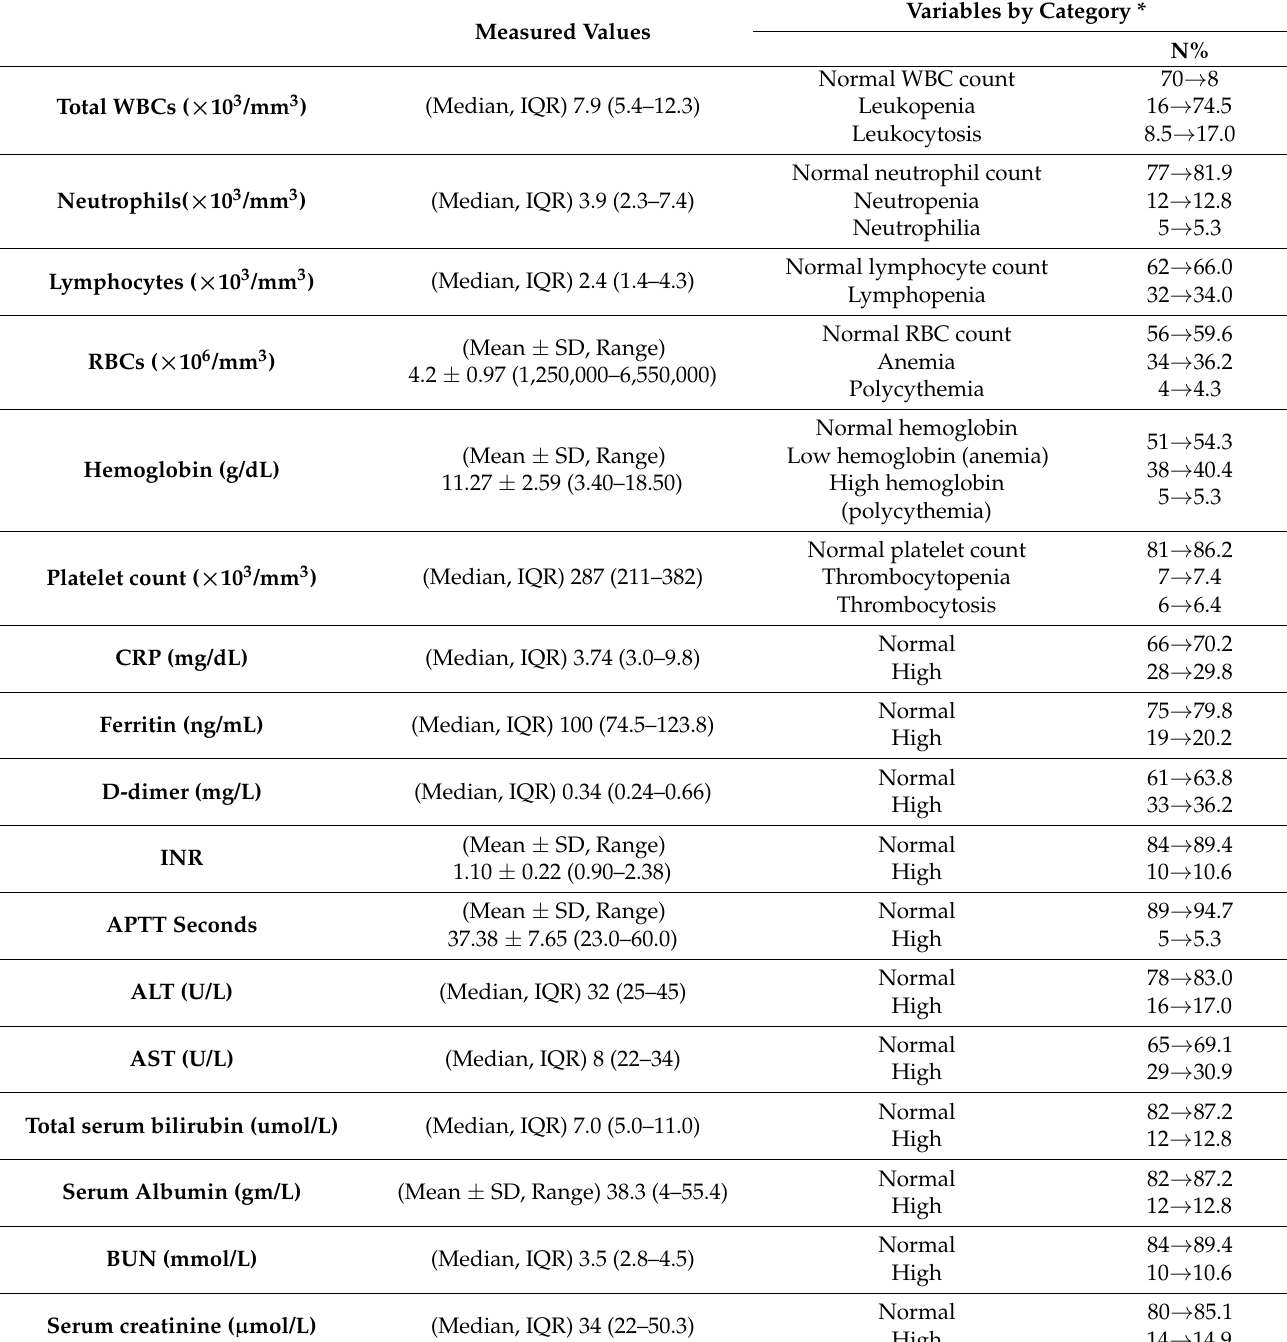
Table 2. Laboratory findings of the whole studied group (N =